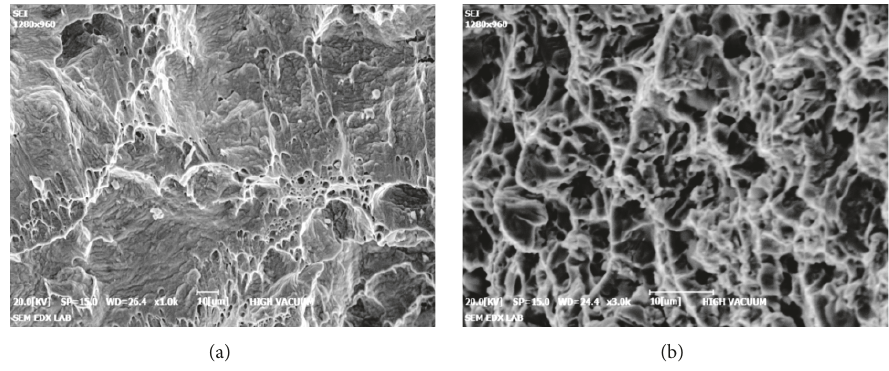
Figure 11: SEM micrographs at the fractured portion of (a) parent metal and (b)